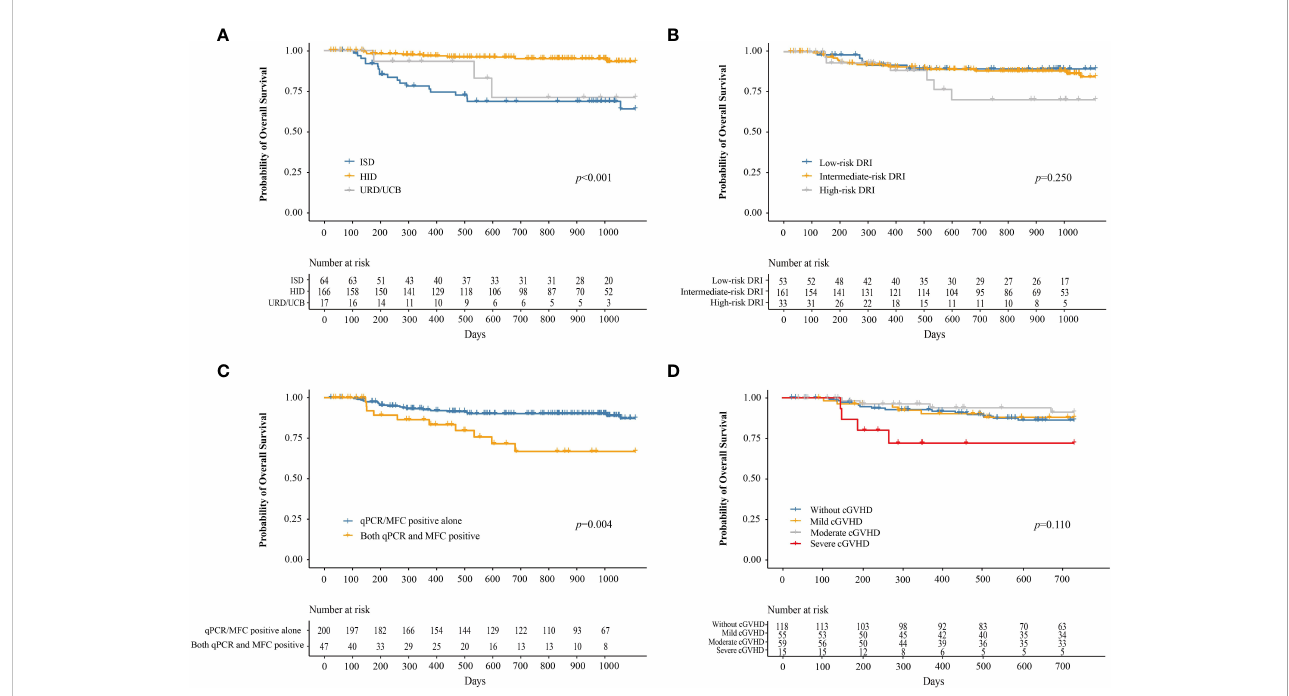
FIGURE 6 The probability of OS after preemptive IFN- a therapy for patients receiving ISD, HID, and URD/UCB transplantation (A) , for patients in the low-, intermediate-, and high-risk DRI groups (B) , for patients with qPCR/MFC positive alone and both qPCR and MFC positive (C) , and for patients without cGVHD, with mild, moderate, and severe cGVHD (D) . OS, overall survival; IFN- a , interferon- a ; ISD, identical sibling donor; HID, haploidentical donor; URD, unrelated donor; UCB, unrelated cord blood; qPCR, quantitative polymerase chain reaction; MFC, multiparameter fl ow cytometry; DRI, disease risk index; cGVHD, chronic graft-versus-host